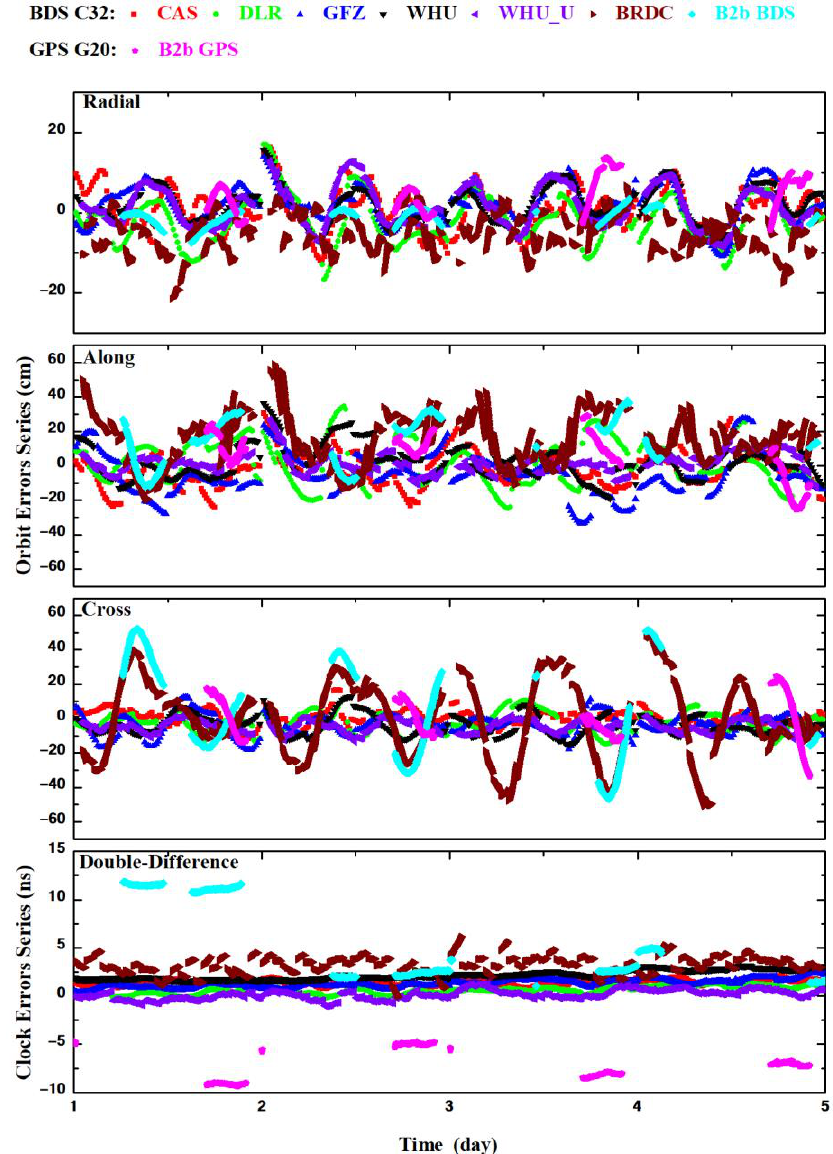
Figure 3. Time series of the orbit radial and clock errors of C32 and G20.